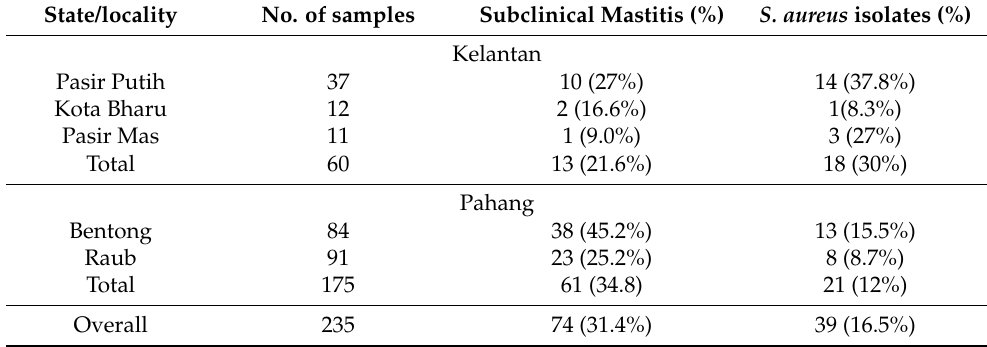
Table 1. The prevalence of subclinical mastitis in different areas in Kelantan and Pahang, Malaysia. State/locality